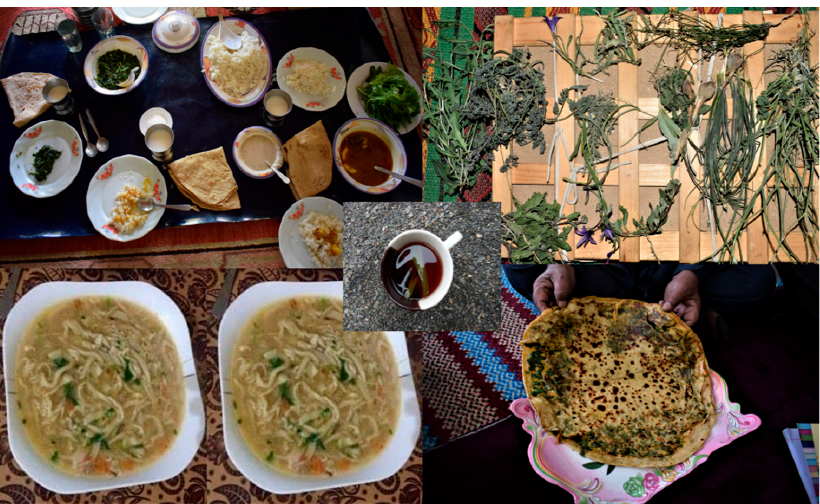
Figure 2. Some of the locally prepared food and herbal